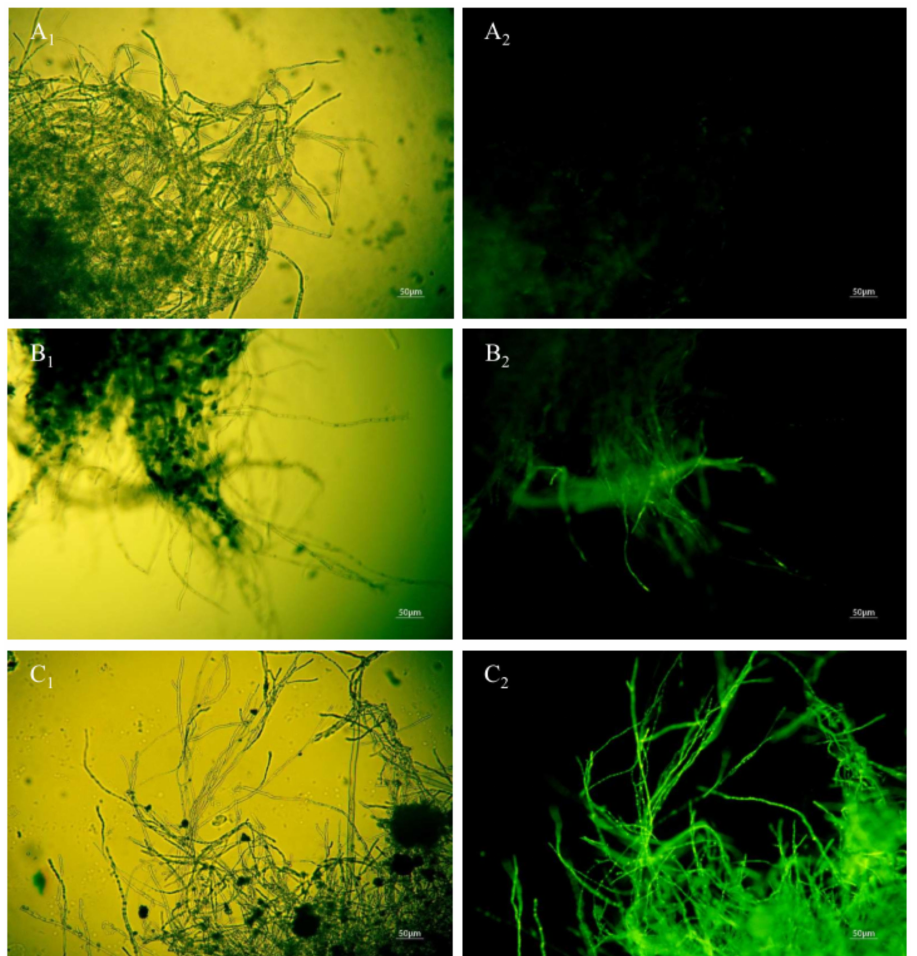
Figure 8. Effect of anti-fungal peptides treatment on membrane permeability of A. carbonarius H9 mycelia ( A 1 , A 2 ), control group under bright field and fluorescent field; ( B 1 , C 1 ), mycelia membrane treated by 1.6 and 6.4 mg/L polypeptides under bright field; ( B 2 , C 2 ), mycelia membrane treated by 1.6 and 6.4 mg/L polypeptides under fluorescent